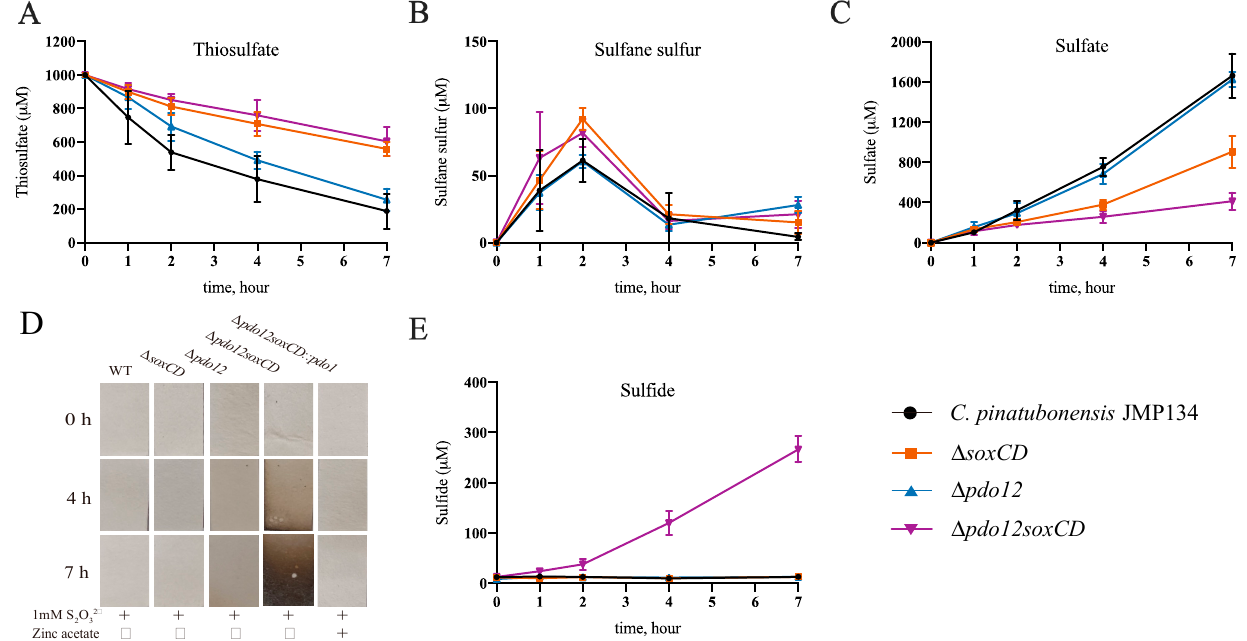
Figure 2. Thiosulfate oxidation by wild-type JMP134 and its mutants. Cells of C. pinatubonensis JMP134, ∆ soxCD , ∆ pdo12soxCD , and ∆ pdo12 were harvested, washed, and resuspended at an OD 600 of 2.0 in 100 mM HEPES buffer, pH 7.0. Then, 1 mM thiosulfate was added to initiate the reaction. Thiosulfate ( A ), sulfane sulfur ( B ), sulfate ( C ), H 2 S gas ( D ), and dissolved sulfide ( E ) were determined at different time points. Except for the H 2 S gas values, all data are the average of at least three samples with SD (error bar).